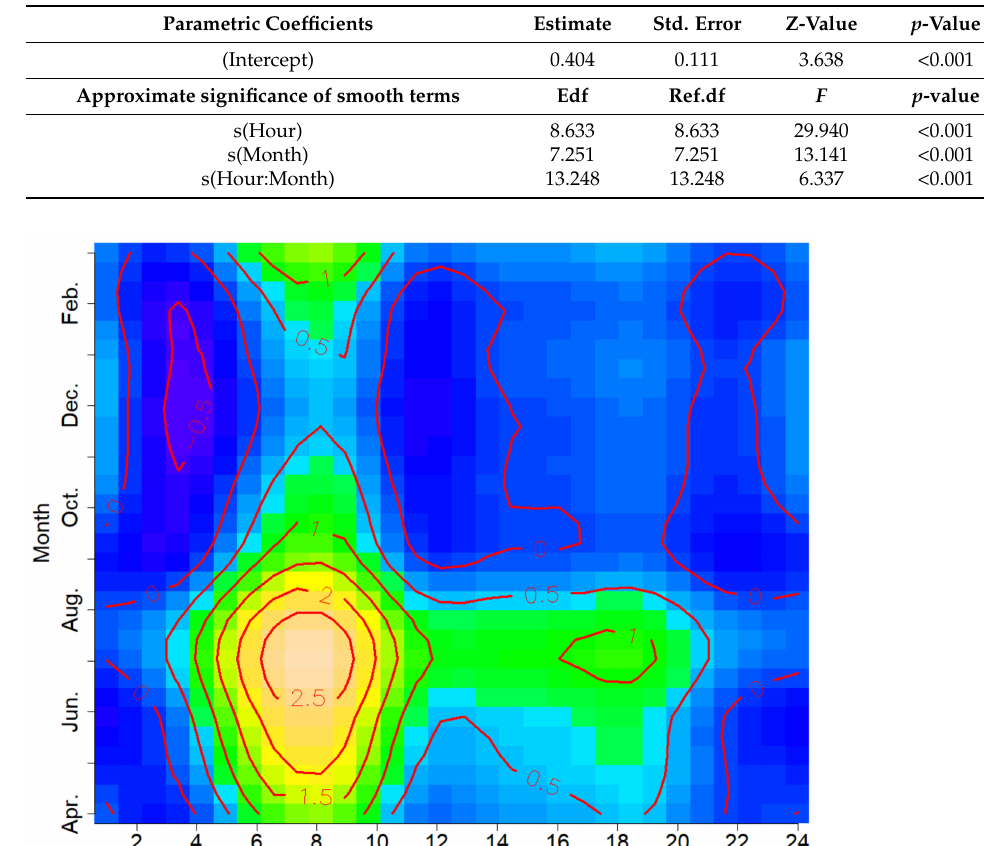
Table 1. Summary of a Gaussian GAMM performed to test the effects of hour, month, and their interaction, on the calling activity of the Oriental Turtle Dove in the YNNR.